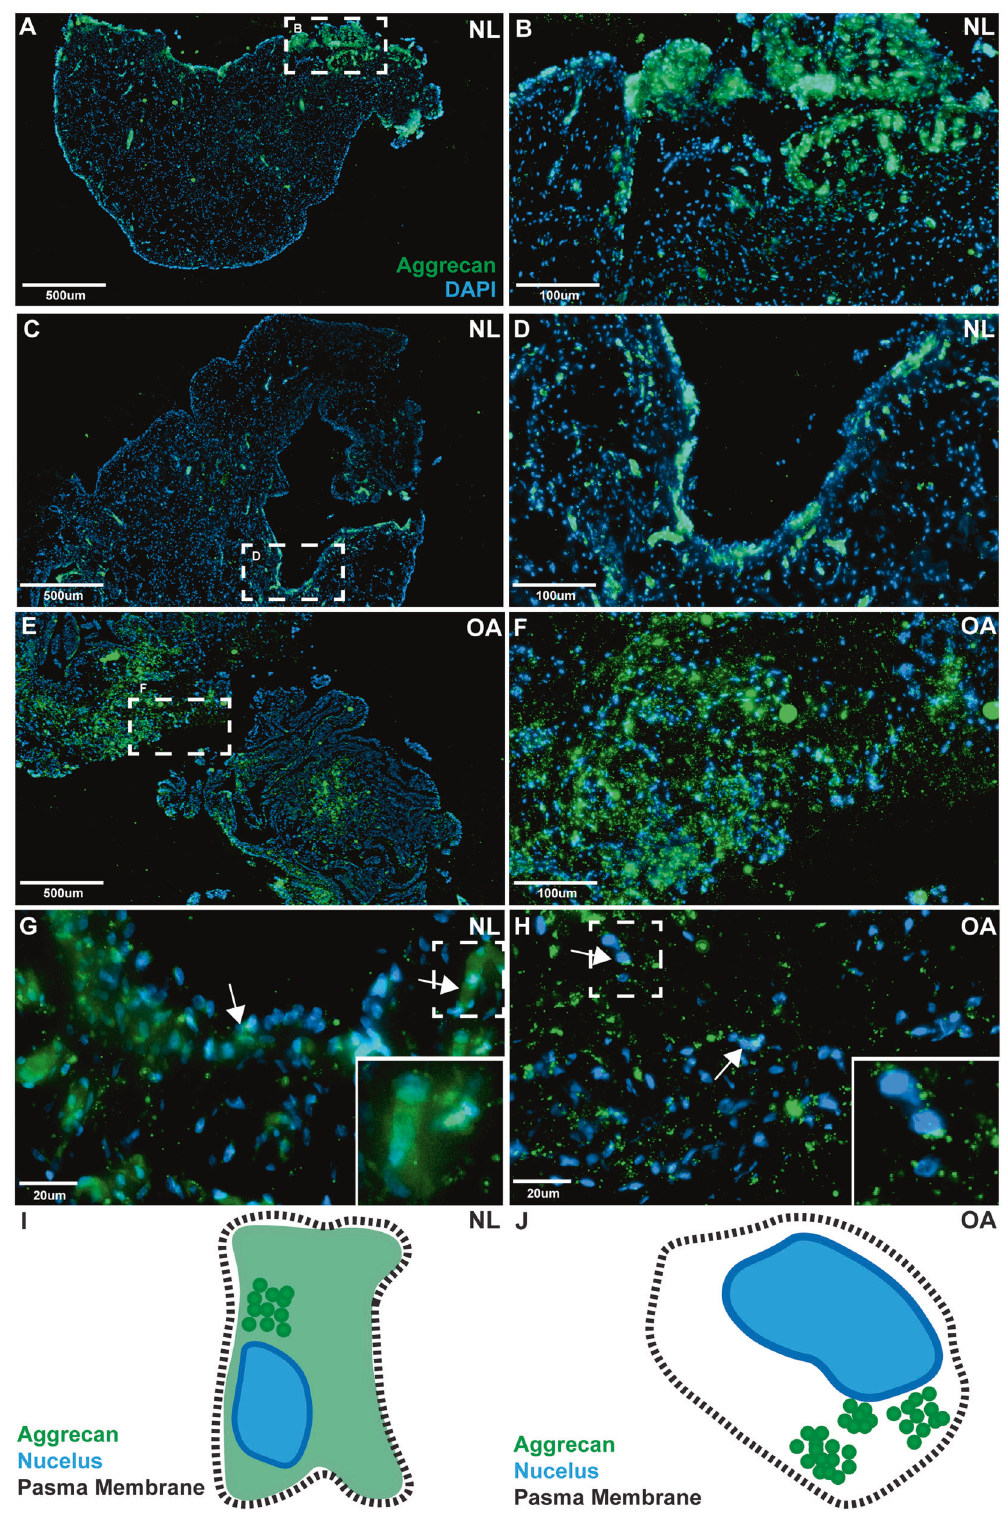
Fig. 4 Aggrecan staining in human synovium. Normal ( n = 8) and OA ( n = 8) synovial biopsy samples were stained with aggrecan and DAPI. In normal (NL) synovium, aggrecan staining was predominantly observed within the intimal layer, but was also observed infrequently within the sub-intima ( A – D two individuals shown as representative examples). In OA synovium, aggrecan staining was observed equally between the intima and sub-intima ( E , F ). The subcellular localization of aggrecan was also different between normal vs. OA samples. In normal samples aggrecan staining was diffuse throughout the cells with areas of increased staining adjacent to the nucleus ( G arrows), while in OA samples a punctate pattern of staining was observed with increased staining adjacent to the nucleus ( H arrows). Diagrammatic representations of aggrecan staining in normal ( I ) and OA ( J ) are also